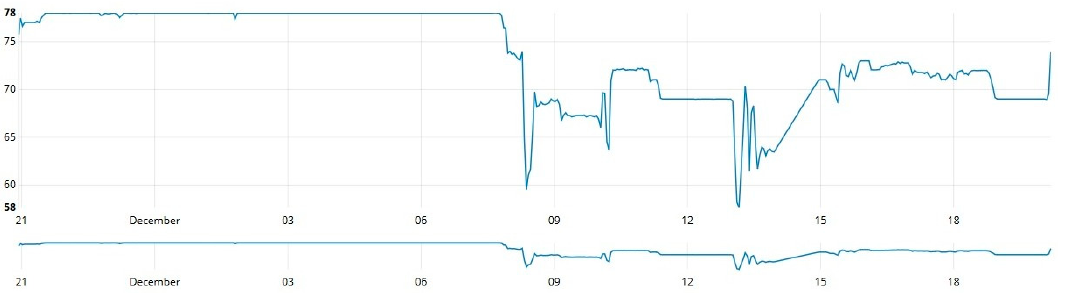
Figure 13. Water depth measurements over time.